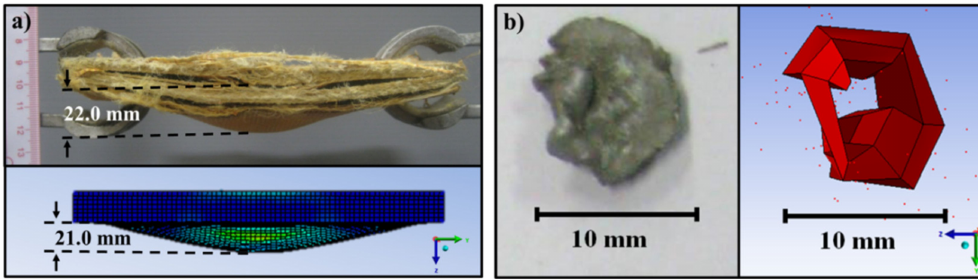
Figure 11. Comparison of ( a ) the depth of penetration and ( b ) the projectile shape after impact as determined by experiment or by numerical simulation. See text for more